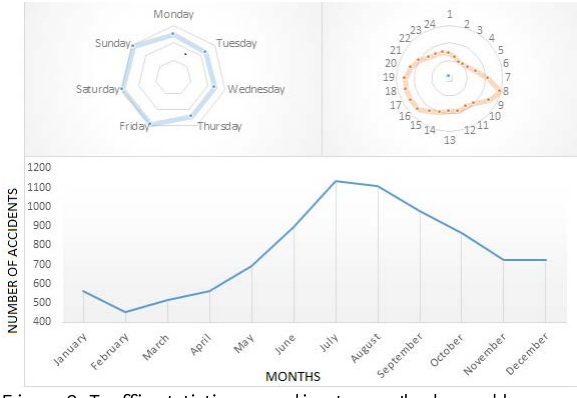
Figure 2. Traffic statistics according to month, day and hour